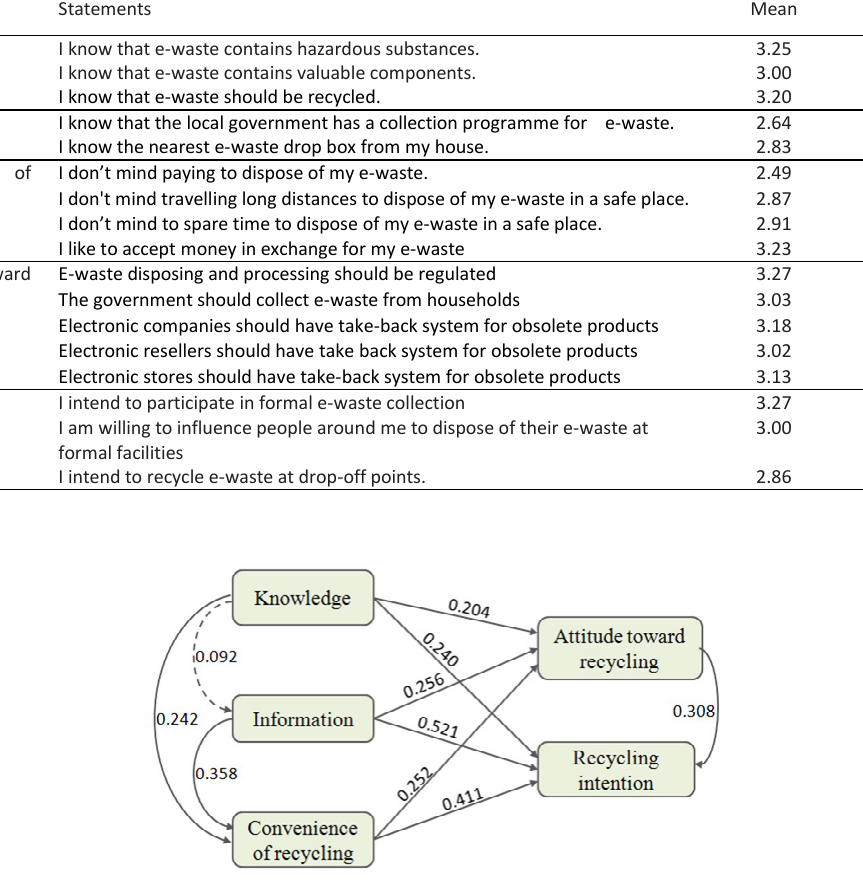
Fig. 4: Relationship among research